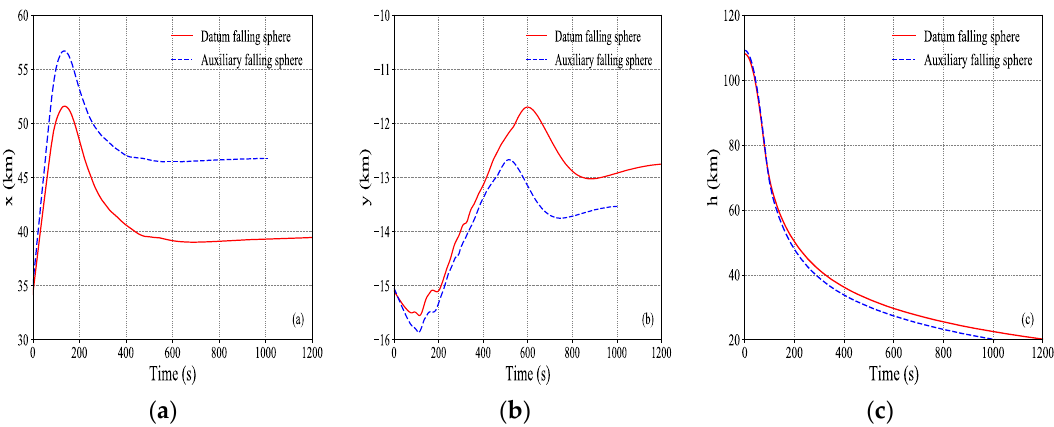
Figure 5. Forward-modeled trajectories of double falling spheres. ( a ) Zonal displacement; ( b ) Figure5. Forward-modeledtrajectoriesofdoublefallingspheres. ( a )Zonaldisplacement; ( b )meridional meridional displacement; ( c ) vertical displacement. displacement; ( c ) vertical